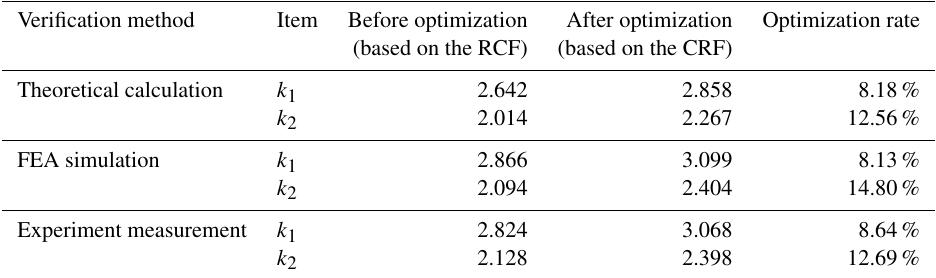
Table 3. Key performance of the precision linear positioning platform.